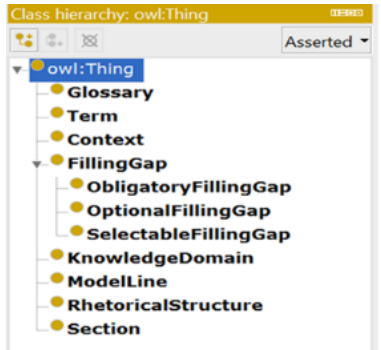
Figure 1. A screenshot of the OWL class hierarchy in Protégé